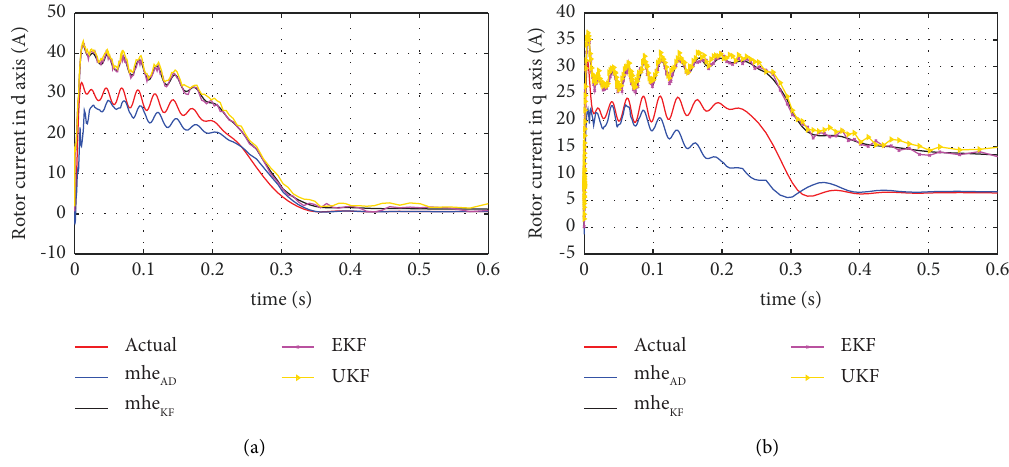
Figure 2: (a) Estimation of rotor current in d axis. (b) Estimation of rotor current in q axis.